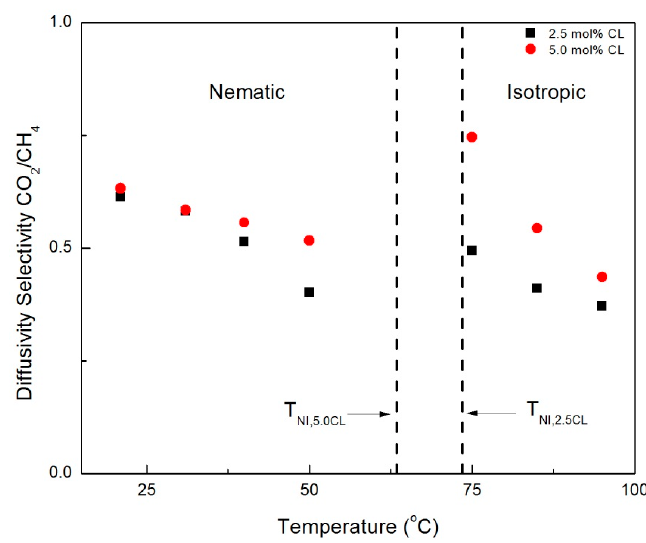
Figure 12. CO 2 /CH 4 diffusivity selectivities in the nematic and isotropic for membranes prepared with Figure 12. CO 2 / CH 4 di ff usivity selectivities in the nematic and isotropic for membranes prepared with 2.5% and 5.0% crosslinker (CNBPh75_2.5 and CNBPh75_5.0). 2.5% and 5.0% crosslinker (CNBPh75_2.5 and CNBPh75_5.0).